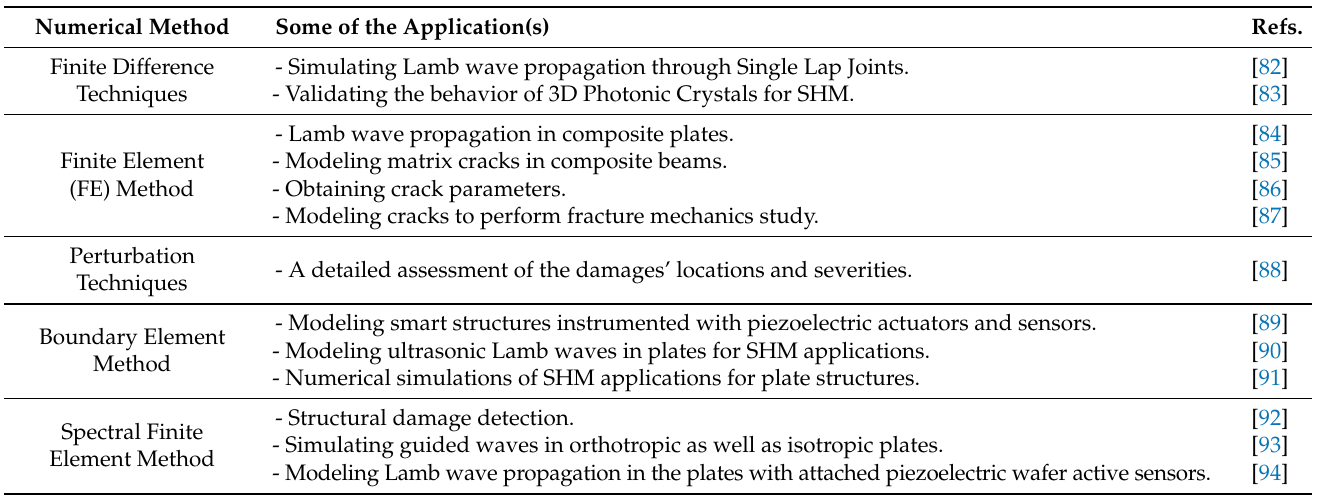
Table 1. Numerical methods and their applications in